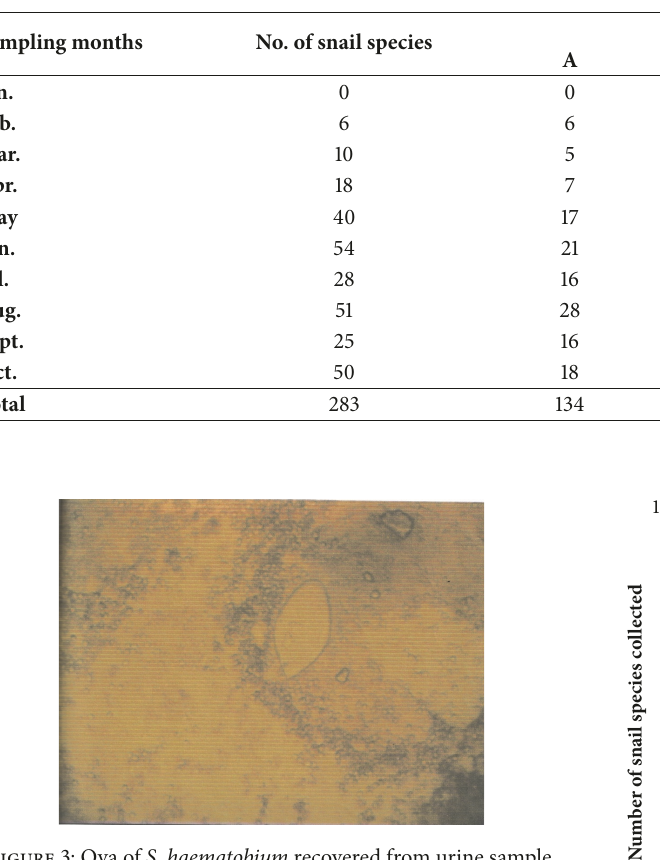
Table 1: Monthly abundance of Bulinus species in various sites sampled.